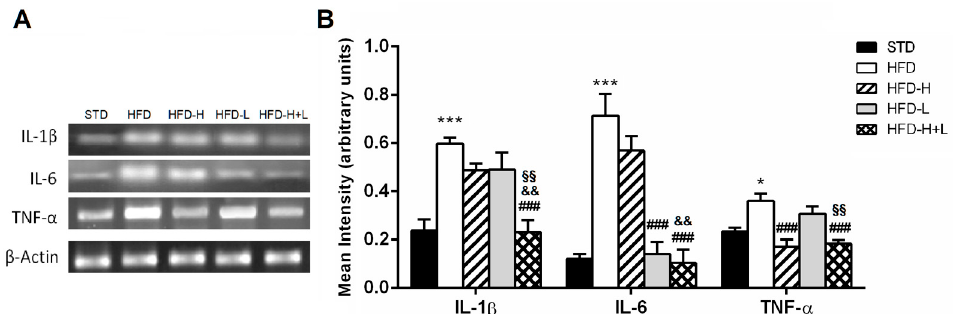
Figure 4. Brain inflammation. ( A ) Representative image of the RT-PCR results and ( B ) mRNA levels of IL-1 β , TNF- α and IL-6 in the mouse brain of different groups. Data are mean values ± S.E.M. (n = 8/group). * p < 0.05, *** p < 0.001 vs. STD mice; ### p < 0.001 vs. HFD mice, && p < 0.01 vs. HFD-H mice; §§ p < 0.01 vs. HFD-L mice.